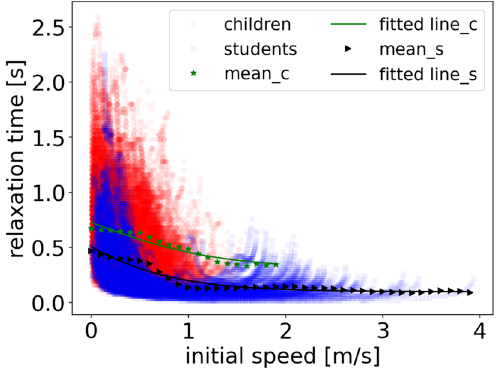
Figure 17. The influence of initial speed on the relaxation time of children (red circles) and students (blue circles). The green stars and black triangles represent the mean data of children and students by applying vertical binning procedure 30 , respectively. The bin size is set as 0.1 m/s. The green and black lines highlight the fitting results of children and students, respectively.